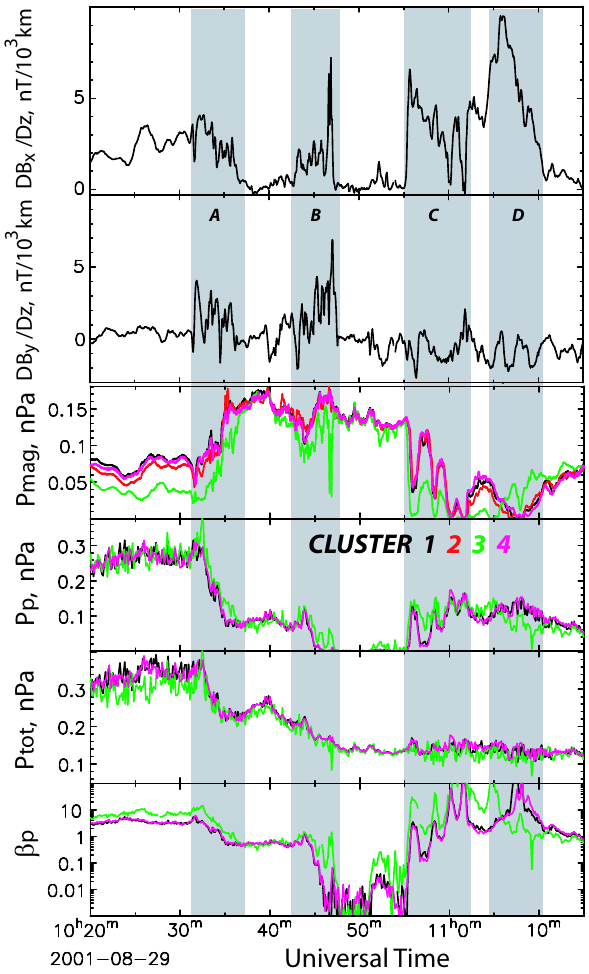
Fig. 4. Time variations of X - and Y -components of the magnetic field vertical gradient, magnetic, plasma and total pressures, and plasma- β parameter during 10:20–11:15 UT 29 August 2001. At 10:28 UT (the electrojet onset time) Cluster was located in the central plasma sheet ( B x ∼ 10–13 nT, N p ∼ 0.3 cm 3 , β p ∼ 3-5). The DB x /DZ , which is a proxy for cross-tail current density, varies from 2 to 4 nT/10 3 km. Starting at ∼ 10:31 UT (interval A ) Cluster detects signatures of plas- moid and post-plasmoid flow: negative variation of B z fol- lowed by an ∼ 7 min long interval of negative B z with mini- mum value of − 5 nT and negative V x about − 500 km/s. Dur- ing interval A the total and plasma pressures drop to 0.1 and 0.2 nPa, respectively, magnetic pressure increases up to 0.15 nPa, and β p ∼ 0.9. At ∼ 10:46 UT (interval B ) a negative variation of X and Y magnetic field components, associated with tailward pro- ton flow with velocity of − 800 km/s, were detected by the most southern s/c 3. At the same time the other three space- craft detect no plasma flow and a magnetic field of 20 nT. The DB x /DZ is ∼ 6 − 7 nT/10 3 km, which corresponds to a current density of about 4 nA/m 2 . The value of DB y /DZ is also about 6 nT/10 3 km, thus the current has a